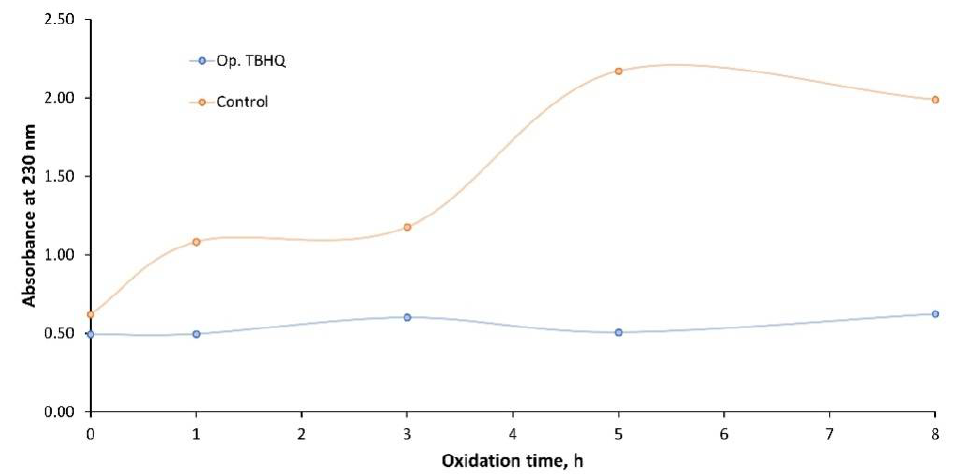
Figure 15. Effect of TBHQ addition on FOBL absorbance in UV during oxidation.